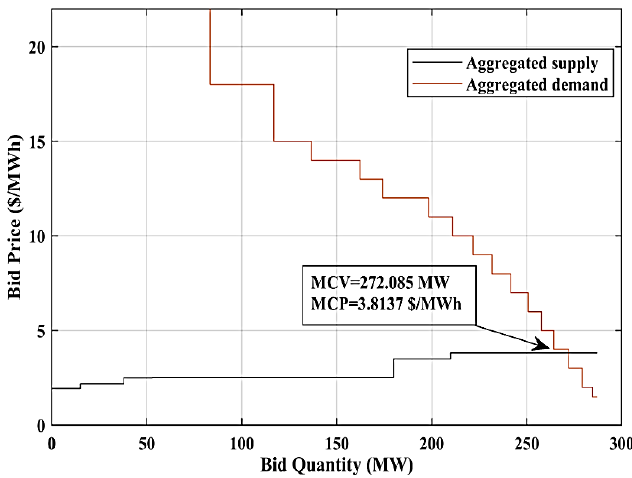
Figure 7. Market clearing simulation with joint WF and PHS system. Table 2. MCP and MCV with and without joint WF and PHS systems for modified IEEE 30 bus